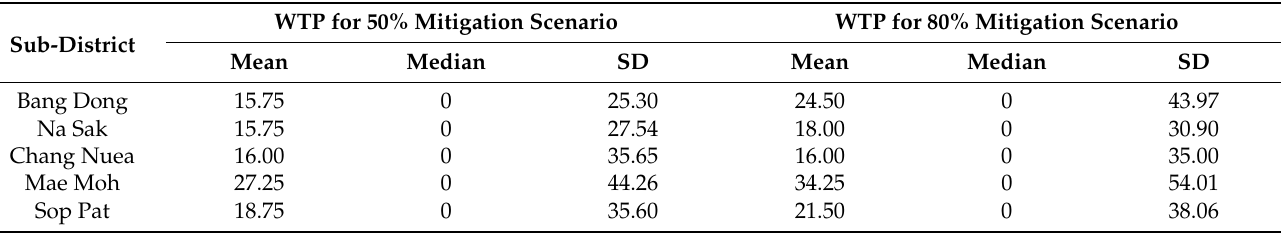
Table 8. Individual willingness to pay (WTP) (THB per month) for mitigation of atmospheric pollutants under the two hypothetical mitigation scenarios for each sub-district ( n = 200).